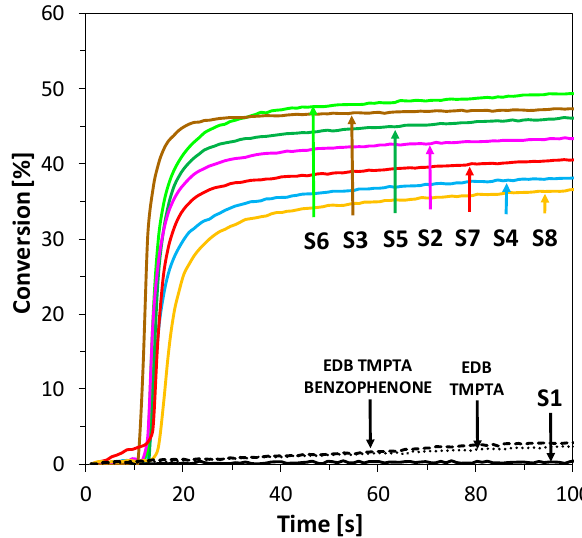
Figure 10. Conversion of double bonds of TMPTA recorded during free-radical photopolymerization with ethyl 4-dimethylaminobenzoate (EDB, 1.5% w / w ) and 2-amino-4,6-diphenyl-pyridine-3-carbonitrile derivatives (0.2% w / w ) under visible-LED 405 nm (6 mW / cm 2 ) irradiation. The irradiation starts at t = 10